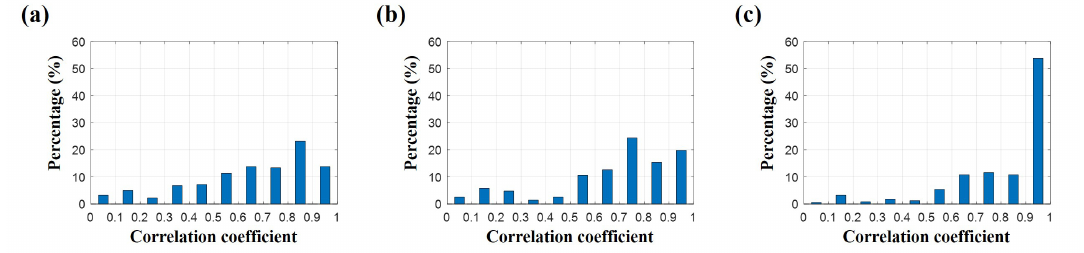
Figure 15. Arrivals less than 20 ◦ are used for the inversion of sound speed profile. Percentages of cases corresponding to correlation coefficients ( x -axis) according to three numerical experiments using different objective functions. Limited information related to the position is used for ( a ) and all available information is used ( b ) without and ( c ) with the normalization,